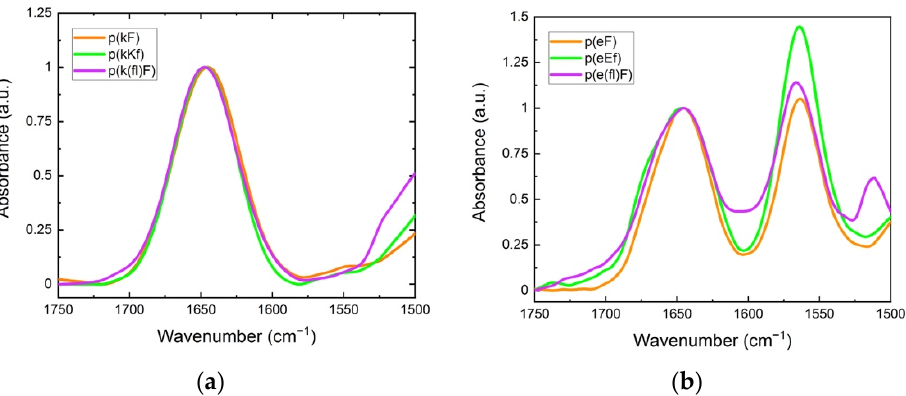
Figure 3. FTIR spectra: ( a ) polycation; ( b ) polyanion sequences. The peak at around 1645 cm − 1 is characteristic of the unordered (random coil) conformation. The signal at 1564 cm − 1 is due to the sidechain stretching of the carbonyl group of glutamic acid. The signal for the carbon-carbon stretching vibration of the fluoro-phenylalanine aromatic ring is observed at 1510 cm − 1 .